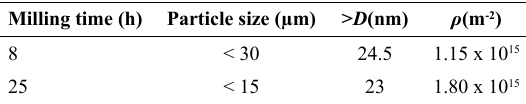
) values in the grain 2